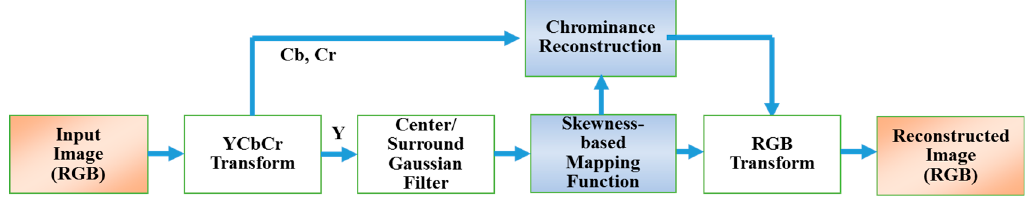
Figure 1. Flowchart of the proposed method.